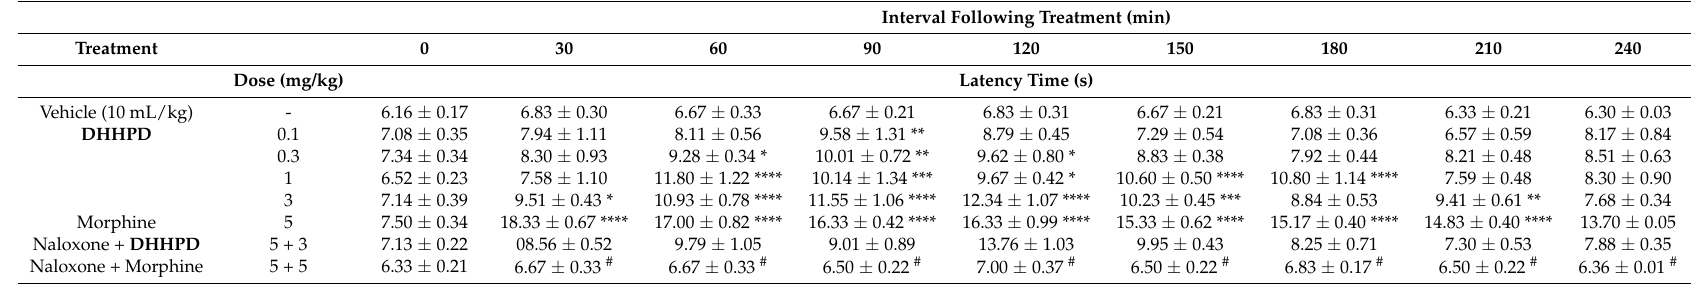
Table 1. Effect of DHHPD against the hot-plate test in